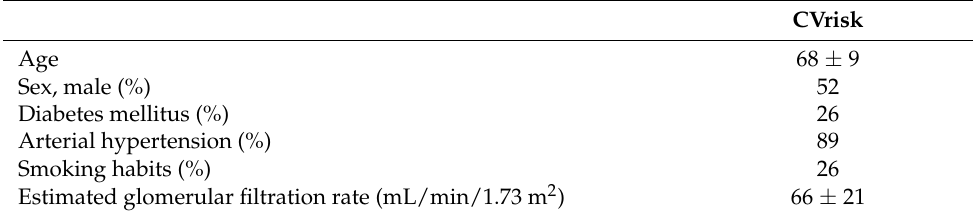
Table 1. Clinical data of CABG patients included in the study.